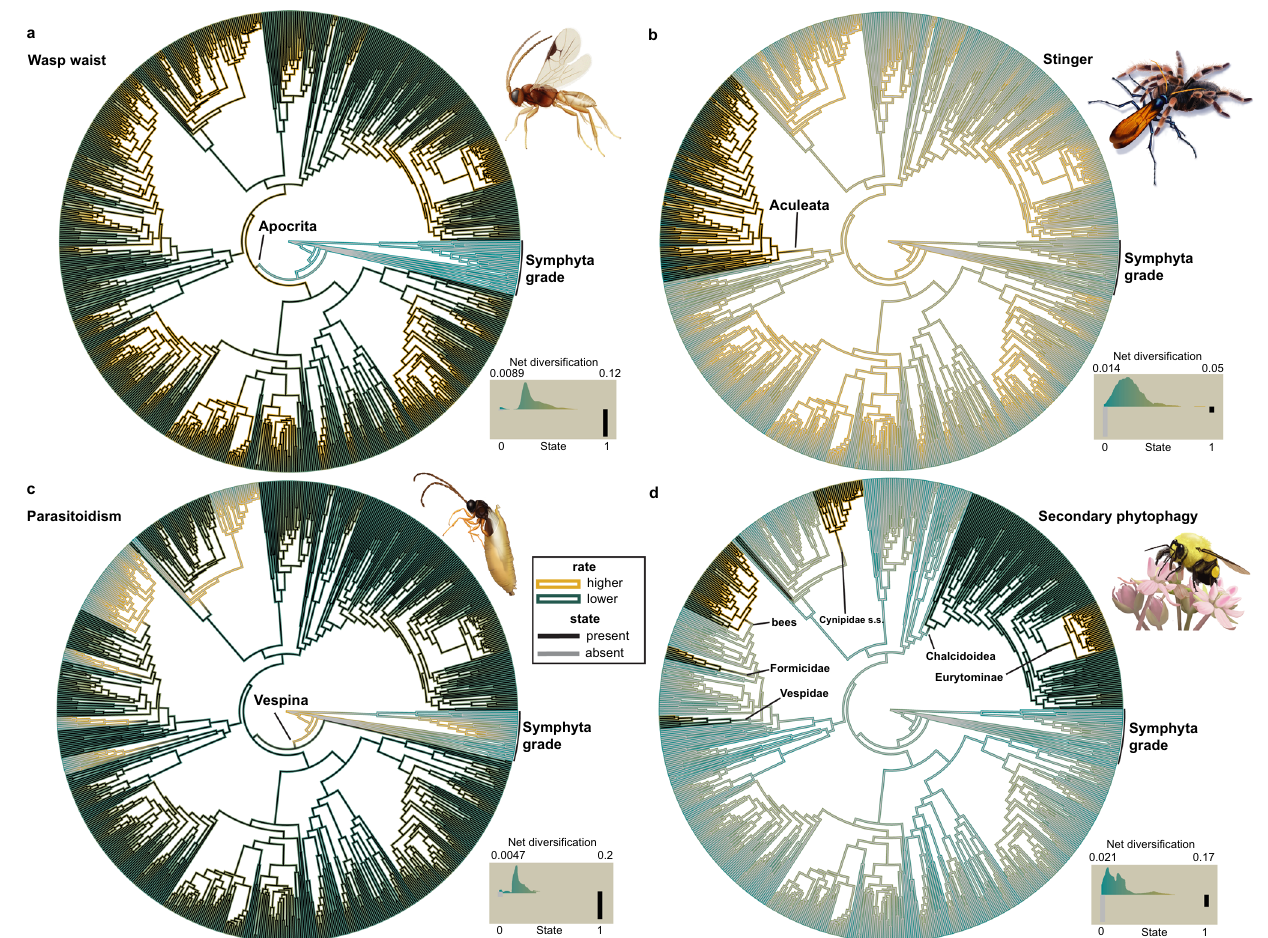
Fig. 4 | Trait-dependent diversi fi cation analyses. We tested 30 models of trait- dependent and trait-independent diversi fi cation in the HiSSE framework 48 for the four putative key innovations and plotted net diversi fi cation rates and state reconstructions from the best- fi tting model onto the Hymenoptera phylogeny. All results shown were based on topology C-1. Inner branch colors represent the pre- sence/absence of the respective states (black=presence; gray=absence); outer branch colors represent the net diversi fi cation rate (highest=gold, lowest=dark cyan). Clades discussed in the context of the results are labeled. The histogramsin the lower right of each panel represent the distribution of net diversi fi cation rates associated with the observed states (0=absent, 1=present). a Wasp waist, model: